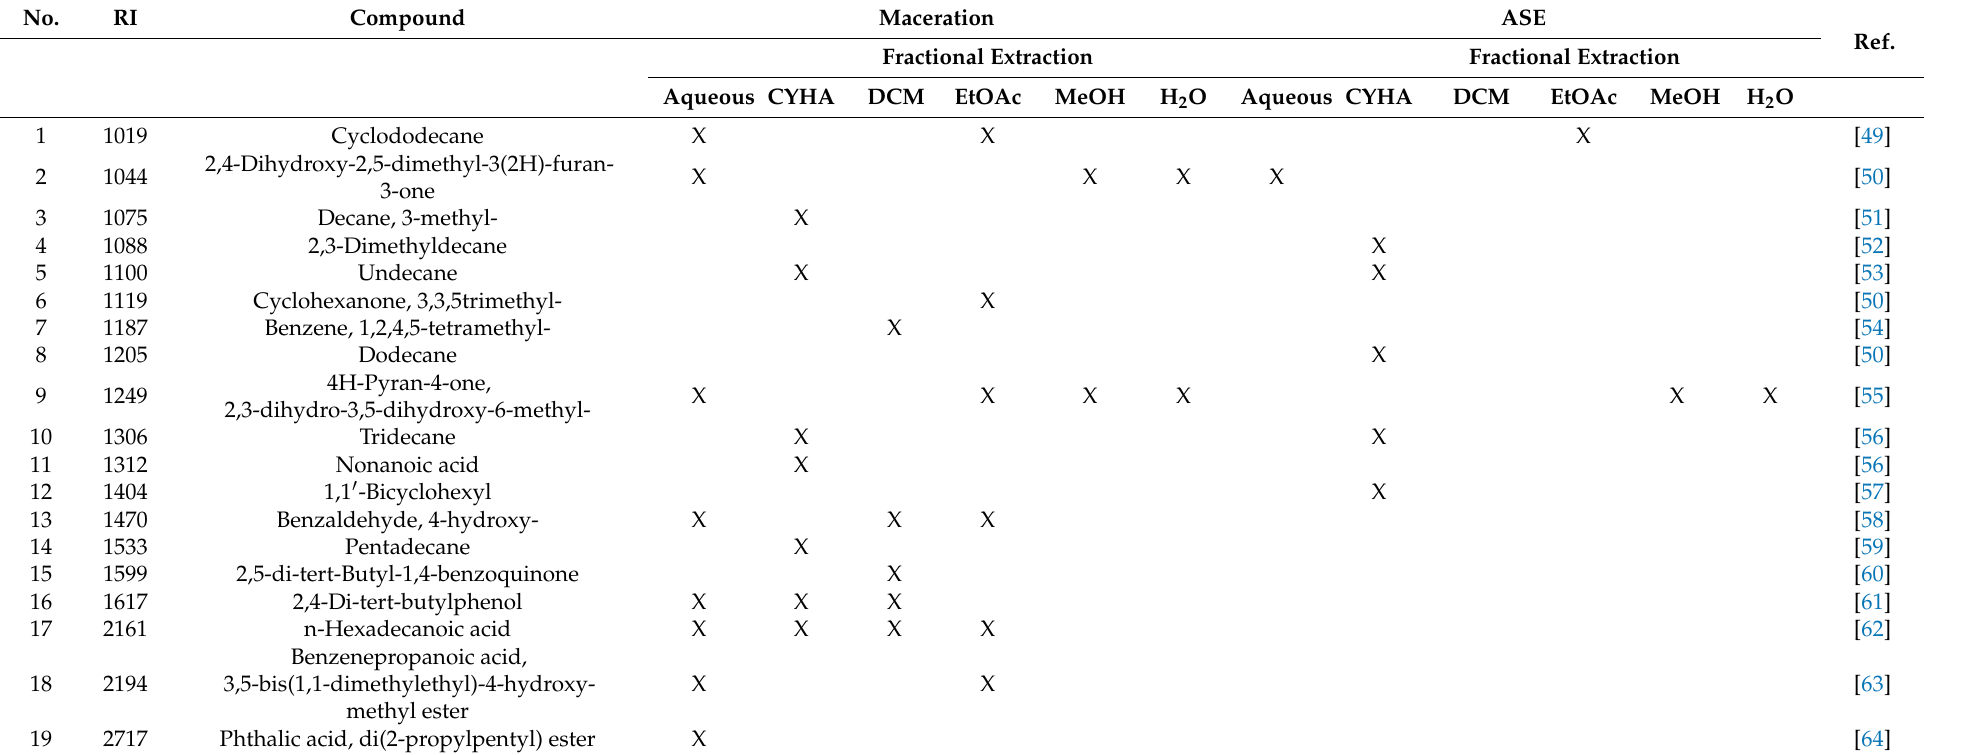
Table 4. Identification of volatile compounds by GC-MS of the extracts of V. vinifera stem (before derivatization) (CYHA: cyclohexane, DCM: dichloromethane, EtO: ethyl acetate, M: methanol, H: H 2